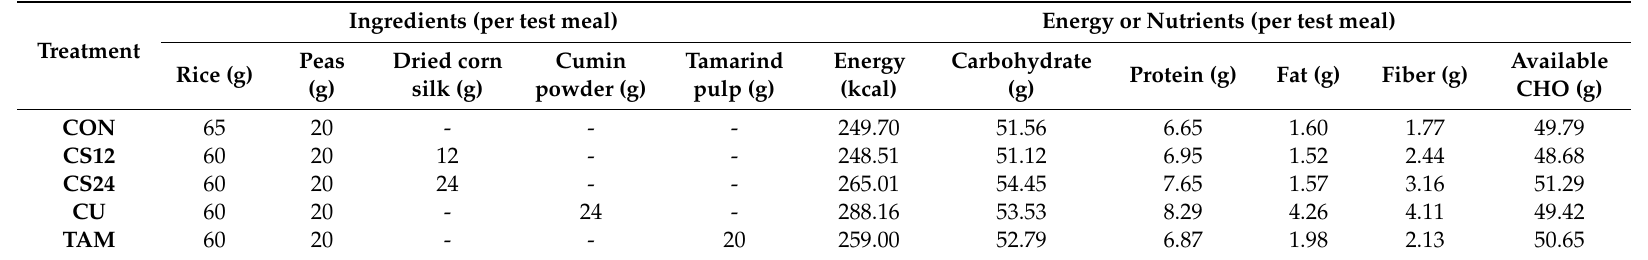
Table 1. Food ingredients, energy content, and nutrient composition of the test